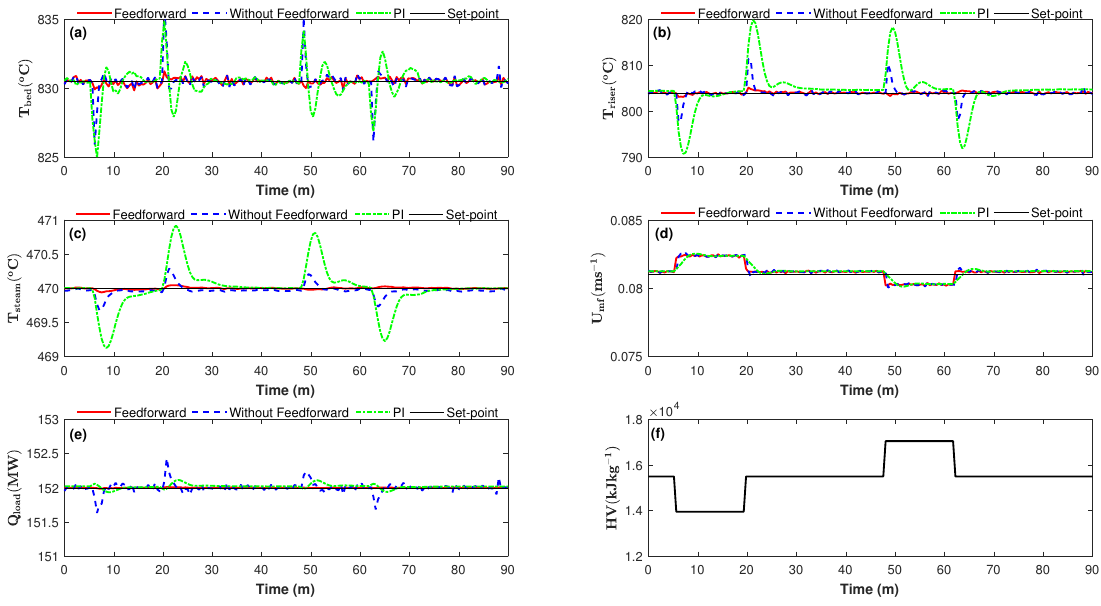
Figure 9. Measured output response to a step change in the fuel’s heating value ( f ) to the bed temperature ( a ); riser temperature ( b ); steam temperature ( c ); minimum fluidization ( d ); and load ( e ). The figures represent feedforward and without feedforward MPC control, with reference PI control, and corresponding set-points.